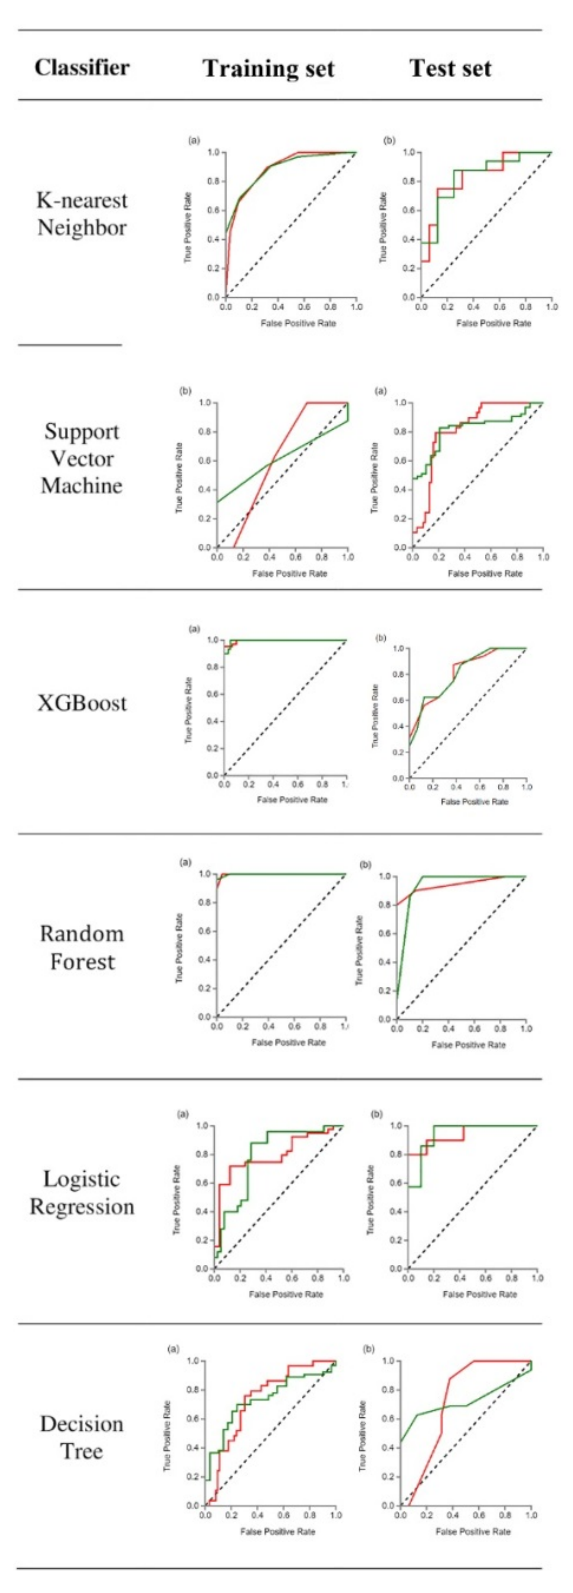
Figure 5. The figure shows the results of the 2nd modeling ROC curve analysis results for the training and test data for differentiating between PHs and PCTs. Note that green—PHs and red—PCTs. ( a ) ROC curve of the training set and ( b ) ROC curve of the test set.